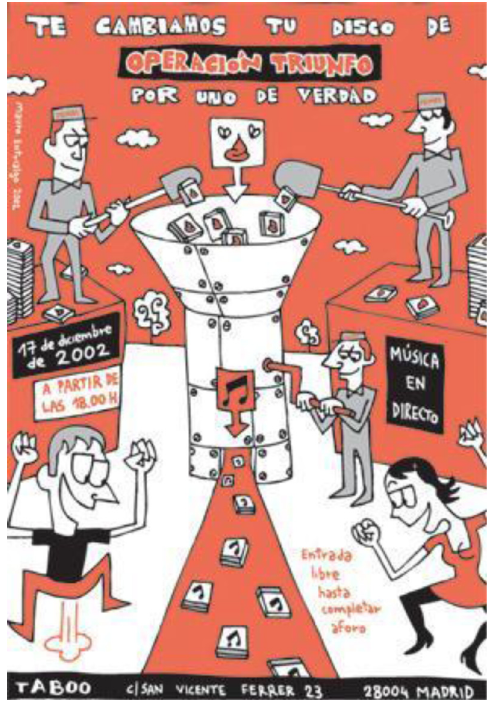
Figure 7. ‘ Otro Timo No ’ , 2002. Source: